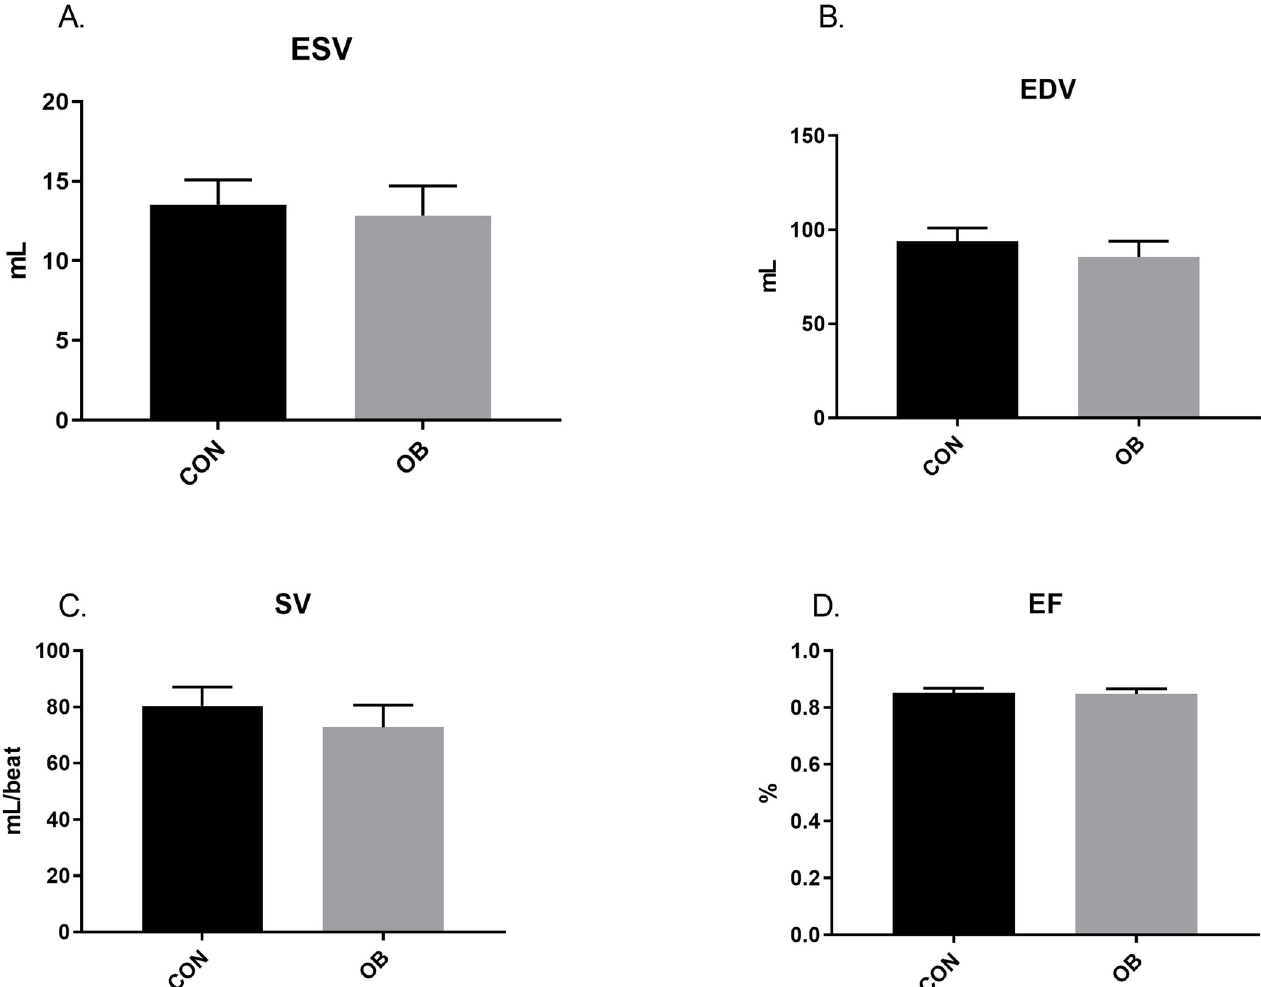
Fig 3. Echocardiography calculations for 2.5-month-old F1 lambs. CONF1 (n = 9) and OBF1 (n = 6) lambs. End-systolic volume (ESV). End-diastolic volume (EDV). Stroke volume (SV). Ejection fraction (EF). † means show a trend (p < 0.1). � means differ (p < 0.05).